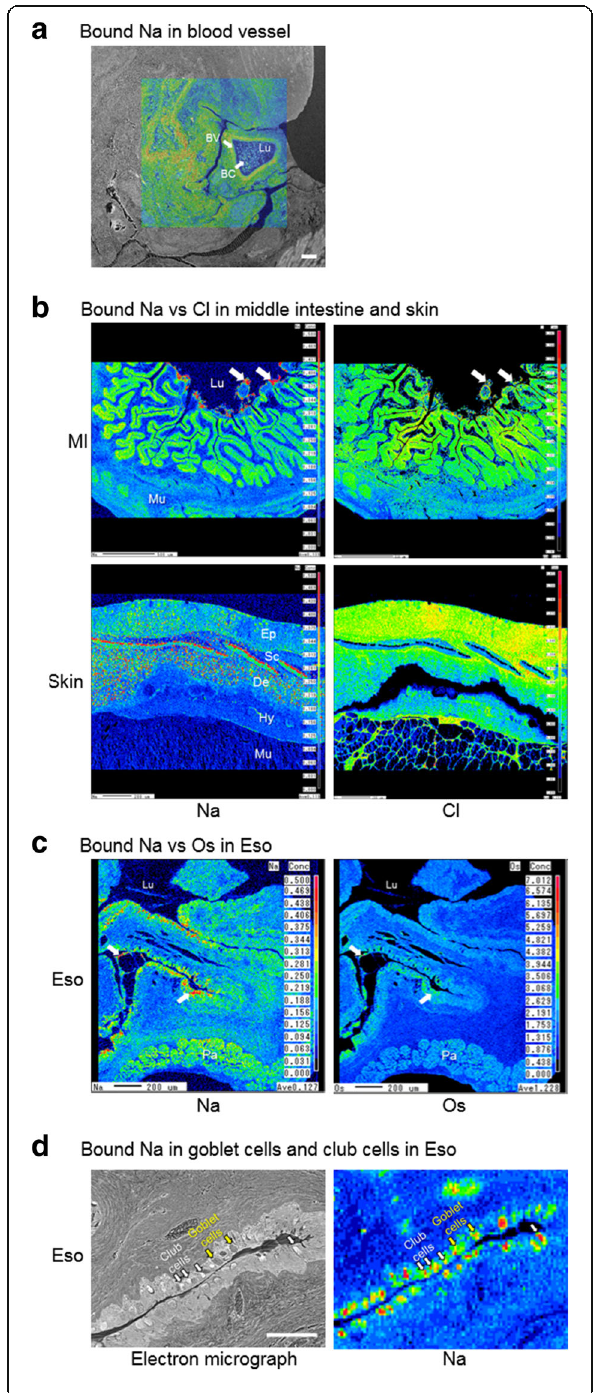
Fig. 5 Bound Na, Cl, and Os in eel tissues. a Bound Na distribution in a blood vessel (BV) of eel after 1 d in SW. The Na-scan is overlaid on the scanning electron micrograph. The blood vessel lumen is filled with blood cells (BC) with low bound Na in the plasma space, indicating that the fixation process has removed Na from the aqueous space, leaving only bound Na in the tissue. Scale bar = 100 μ m. b Comparison between bound Na and Cl distribution in the middle intestine and skin after 3 h and 1 d in SW respectively, showing that their distribution are not paralleled. In scale (Sc), bound Na was high while Cl was almost undetectable. The bound Na was higher than the bound Cl in the mucus secretion and desquamated cell mass (while arrow). c Comparison between Na and Os distribution in esophagus (Eso) after 3 h and 1 d in SW respectively. The distribution of bound Na and Os were not paralleled. Bound Na was high in mucus cells (white arrows), mucus secretion, and desquamated cell mass with average bound Os. d Goblet cells (yellow arrows) and club cells (white arrows) are present on the secretory epithelium of eel esophagus and both cell types contain bound Na. Lu = lumen; Mu = muscle; Pa = pancreas. Lu = lumen; Ep = epidermis; De = dermis; Hy = hypodermis; Mu =